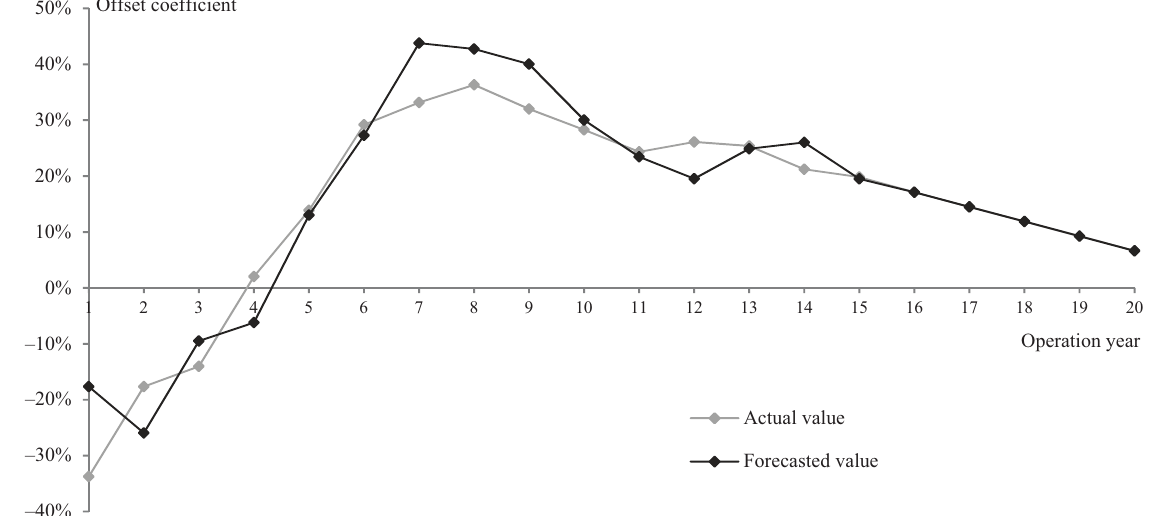
Figure 3. Forecasts of offset coefficient Table 4. Annual compensation from year 16 to year 20